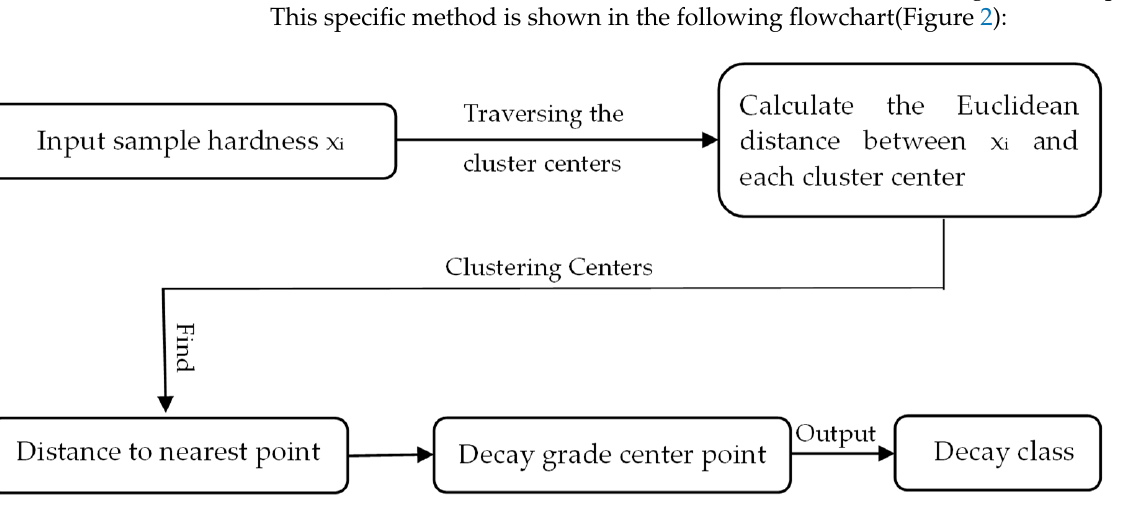
Figure 2. A method of quantitatively dividing the level of log decay by hardness value.